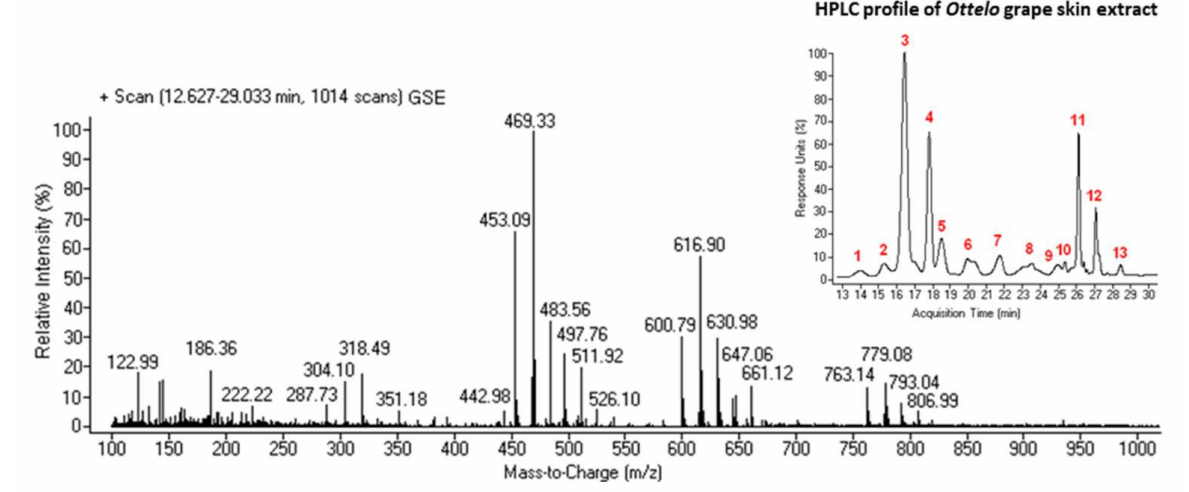
Figure 4. The total ESI/MS positive—ion mode analysis and HPLC profile of Othello grape skin extract. The red numbers represents the peak number so that it can be identified in Table